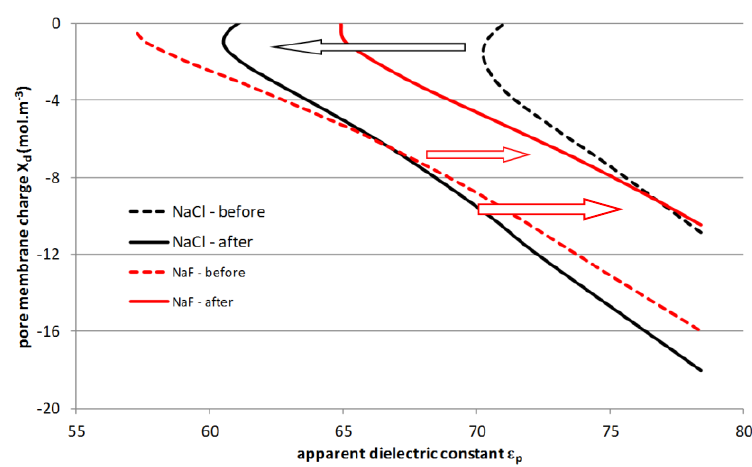
Figure 9. Best-fitted values ( X d , ε p ) for the numerical approximation of rejection curves.